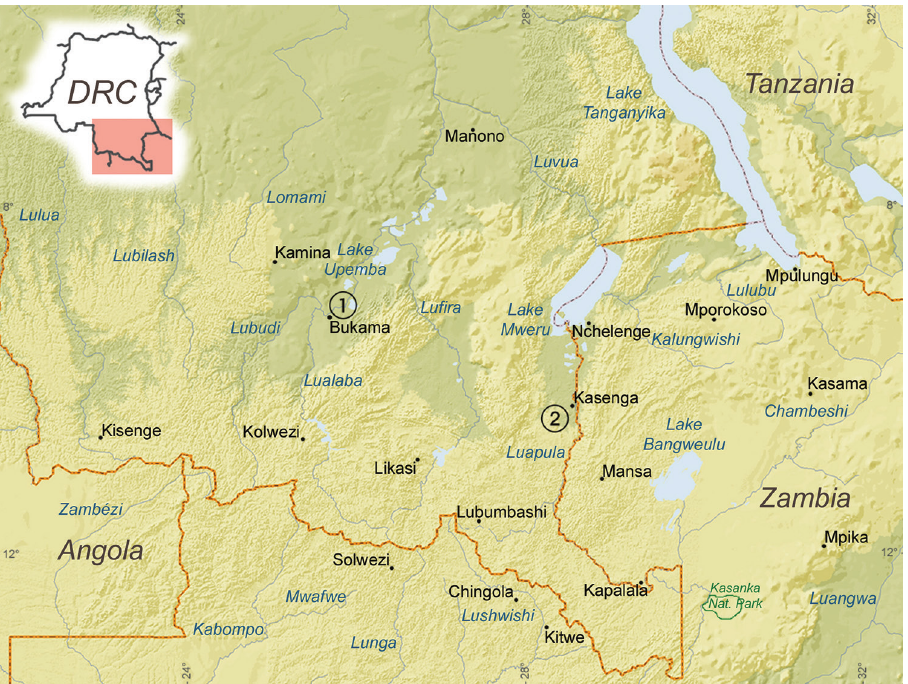
Figure 1. Localities of specimen collections in the Democratic Republic of Congo ( 1 Nothobranchius brieni 2 Nothobranchius sp.